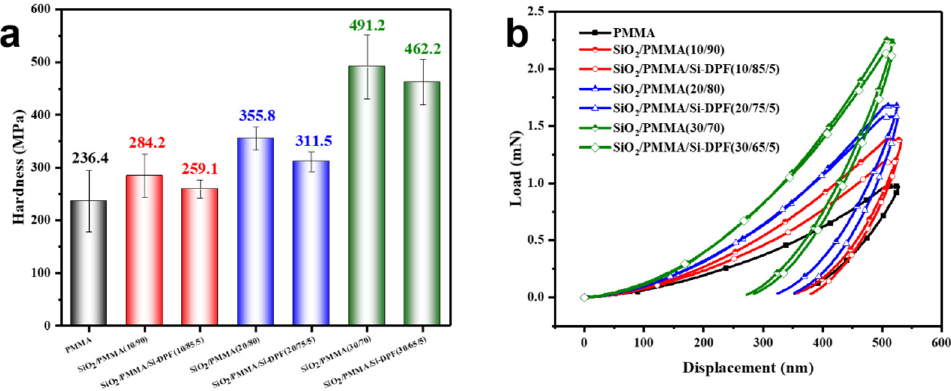
Figure 3. Surface hardness of the PMMA matrix and SiO 2 /PMMA composites. ( a ) Hardness. ( b ) Load ‐ displacement curves. ( b ) Load-displacement